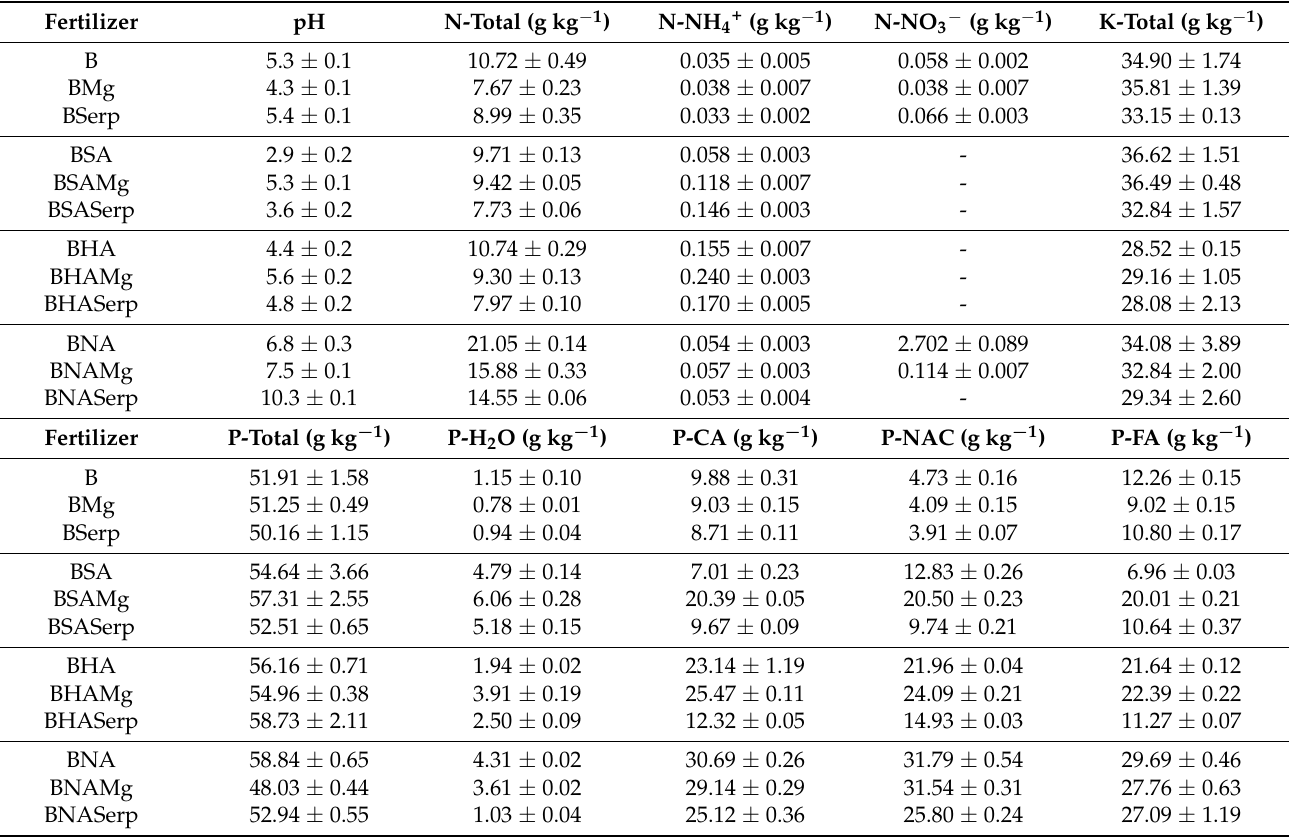
Table A1. pH, nitrogen, phosphorus, and potassium pools and concentrations in biochar-based